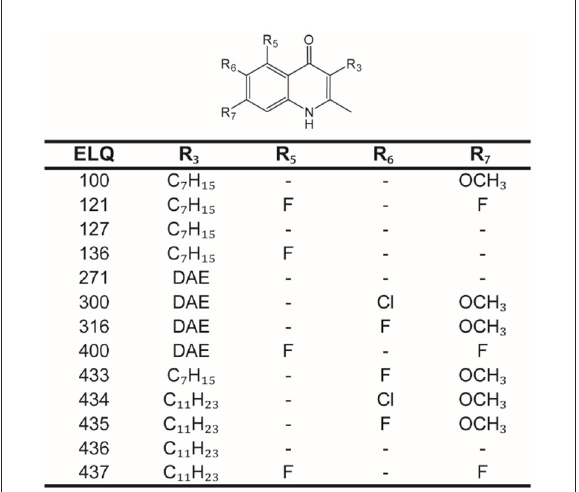
FIGURE1 Structures of endochin-like quinolones (ELQs). Core structure of ELQs with numbered residues for each of the here tested ELQs. ELQ numbers are given in the first column, and the substituents (R3, R5, R6, and R7) are given in the following columns. DAE, diaryl